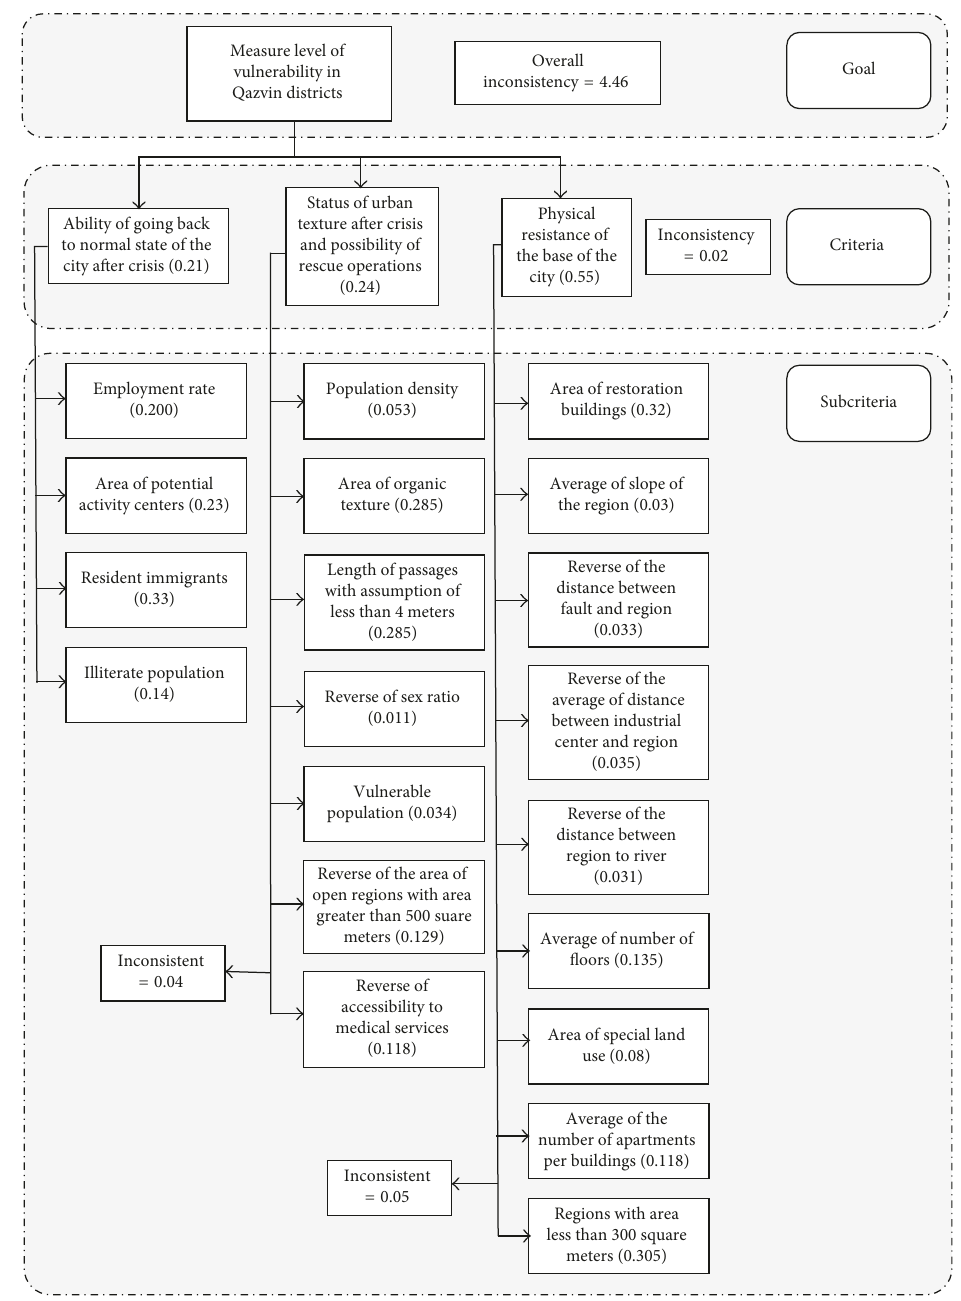
Figure 10: Hierarchy tree of vulnerability assessment for high-risk regions of